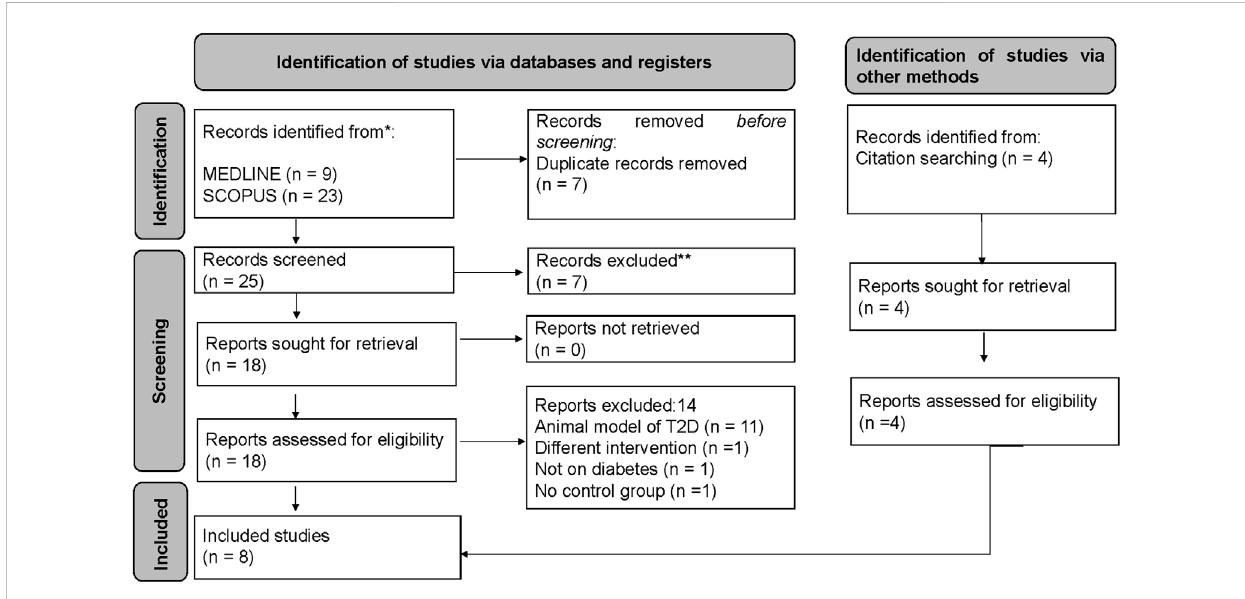
FIGURE 1 PRISMA fl ow diagram showing the study screening